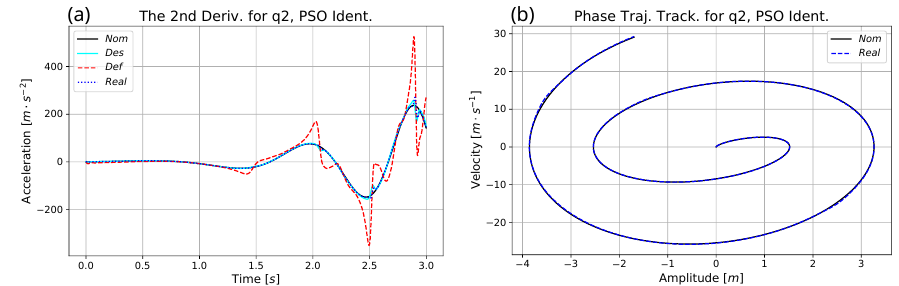
Figure 5. The second time derivatives ( a ) and phase trajectory tracking ( b ) for q 2